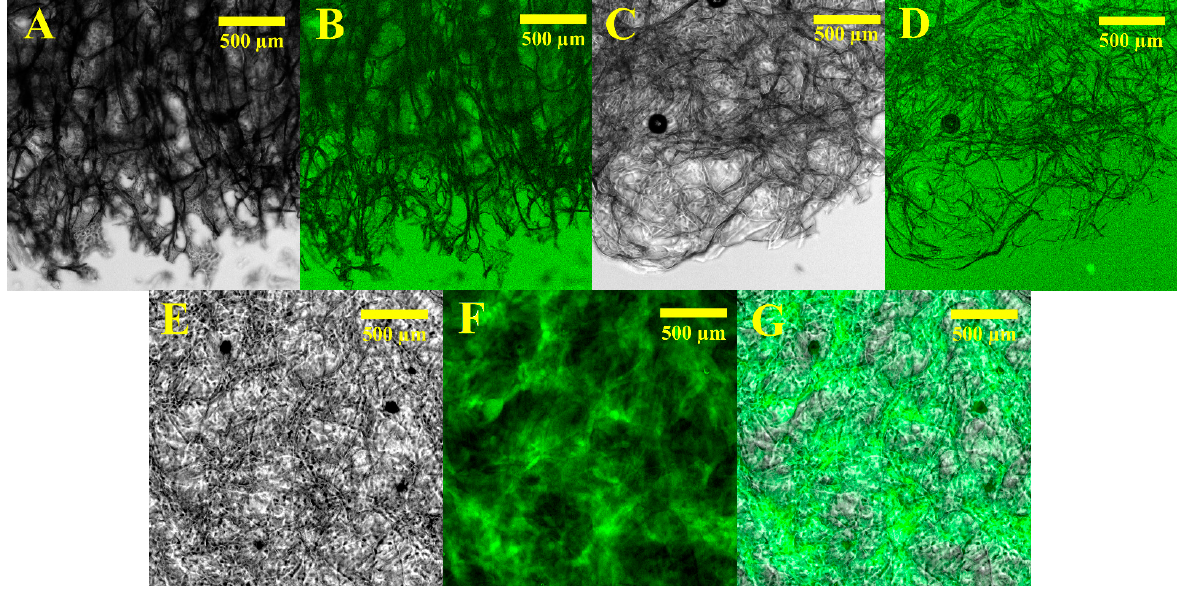
Figure 6. Phase contrast ( A , C , E ) and fluorescence (GFP) ( B , D , F ) images of lyophilized nickel (II) alginate samples with- out ( A , B ) and with ( C , D ) bound EGFP-HisTAG. Second row ( E , F ) shows a rehydrated sample with immobilized EGFP- HisTAG. ( G ) overlap of E and